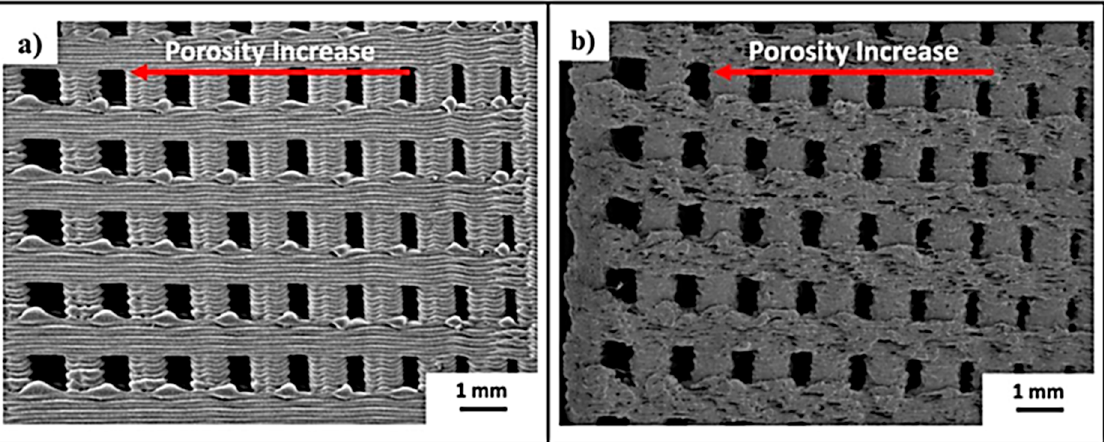
Figure 7. Graded porous structure in 3D-printed ( a ) PLA and ( b ) PLA-graphene scaffold structures [108]. PLA = poly(lactic acid); PLA-graphene = poly(lactic acid)–graphene. Reproduced with permission from Wiley. Table 2. Glass transition (T g ), crystallization (T c ) and melting temperatures (T m ) of PLA and PLA-graphene filaments and 3D-printed samples [108]. PLA = poly(lactic acid); PLA-graphene = poly(lactic acid)–graphene. Reproduced with permission from Wiley.